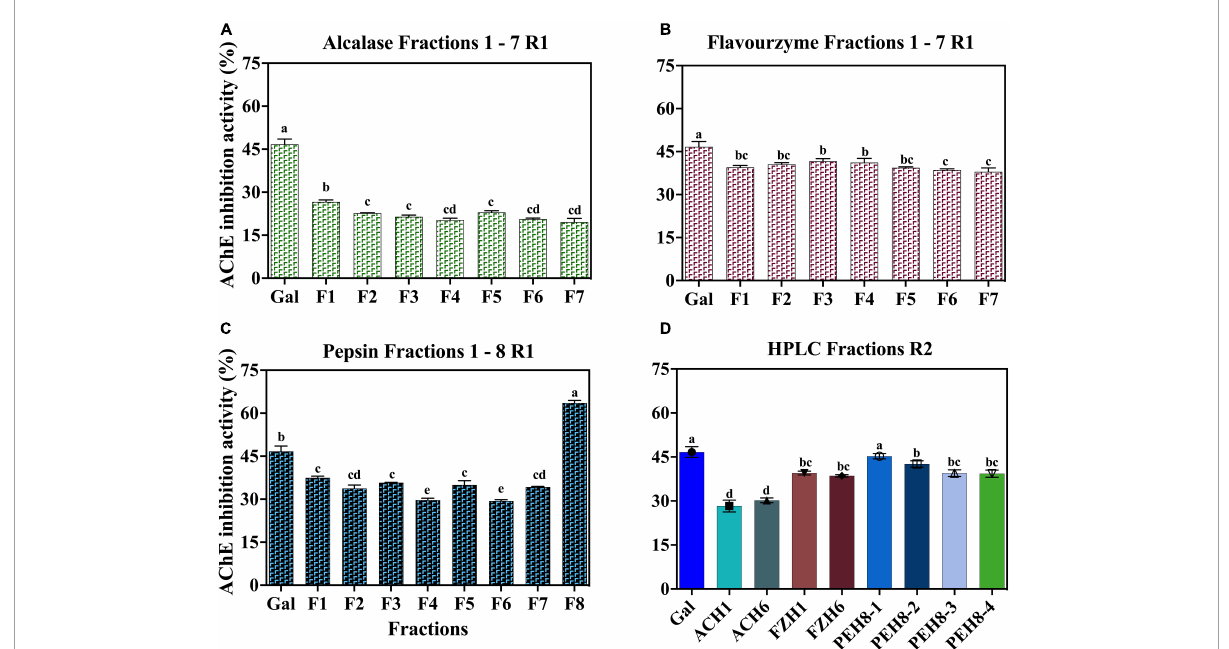
FIGURE2 AChE-inhibitory activity of peptide fractions (30 µ g) obtained after RP-HPLC separation of enzymatic digests of pea protein: First round (A) Alcalase (B) Flavourzyme (C) Pepsin and (D) Second round for all the